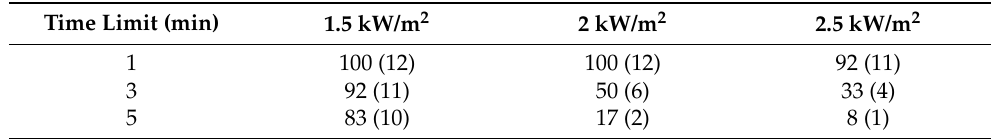
Table 3. The percentiles of the tested population whose skin temperature stayed under 43 ◦ C for 1, 3, and 5 min under the tested radiation intensities. In brackets is given the actual number of test persons who managed the given